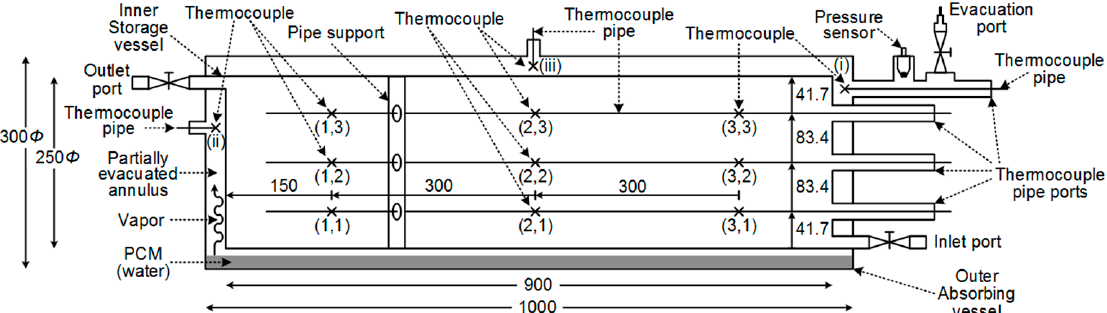
Figure 2. Cross-section of the inner storage vessel, outer absorbing vessel, numbering/positioning of the thermocouples within the inner storage vessel and the annulus positioning of the pressure sensor, inlet, outlet, evacuation, and thermocouple pipe ports [27].